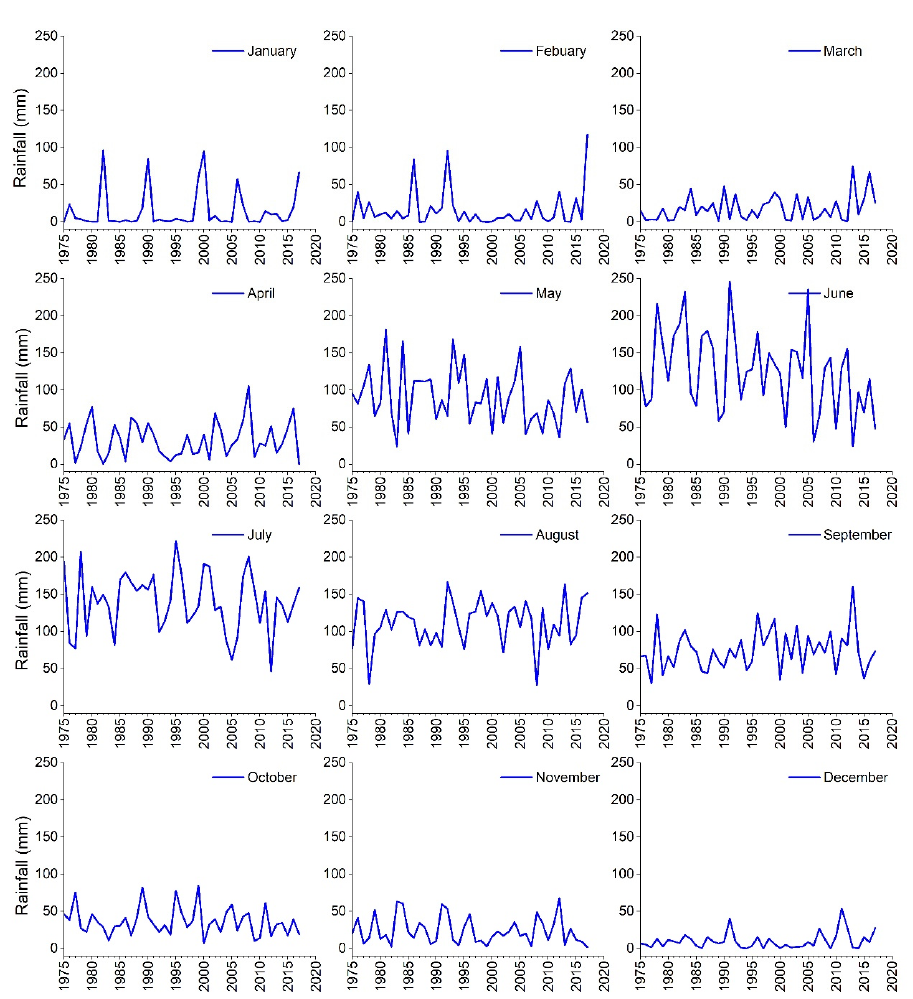
Figure 13. Changing trend in monthly rainfall from 1977 to 2017 in the Gnangara region.